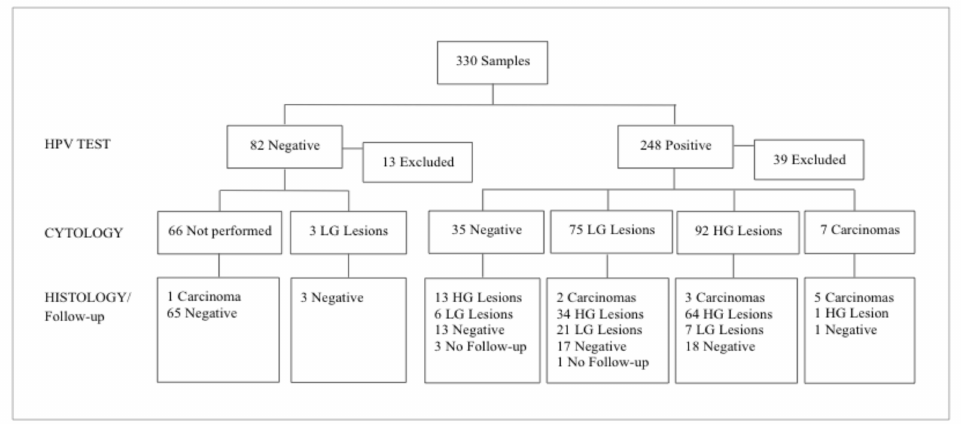
Figure 1. Samples of the study and relative testing results. (Abbreviations: HG: high grade; LG: low